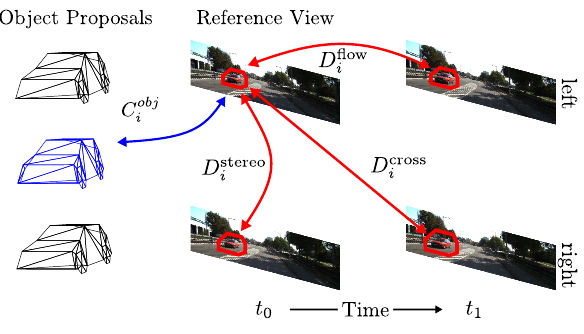
Figure 2. Data and Shape Terms. Each superpixel s i in the reference view is matched to corresponding image patches in the three remaining views. Its shape and motion are encouraged to agree with the jointly estimated 3D object